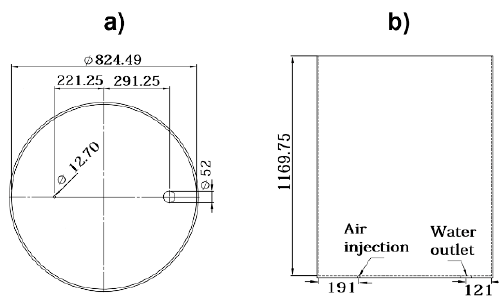
Figure 1. ( a ) Dimensions of the model (mm). ( b ) Position of the nozzle.